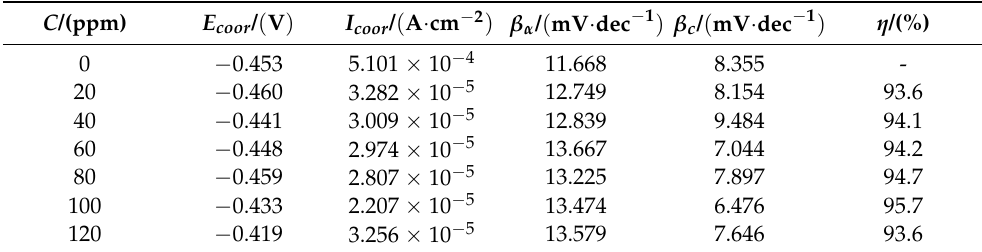
Table 2. Tafel curves parameters of Q235 carbon steel in solutions containing different concentrations of